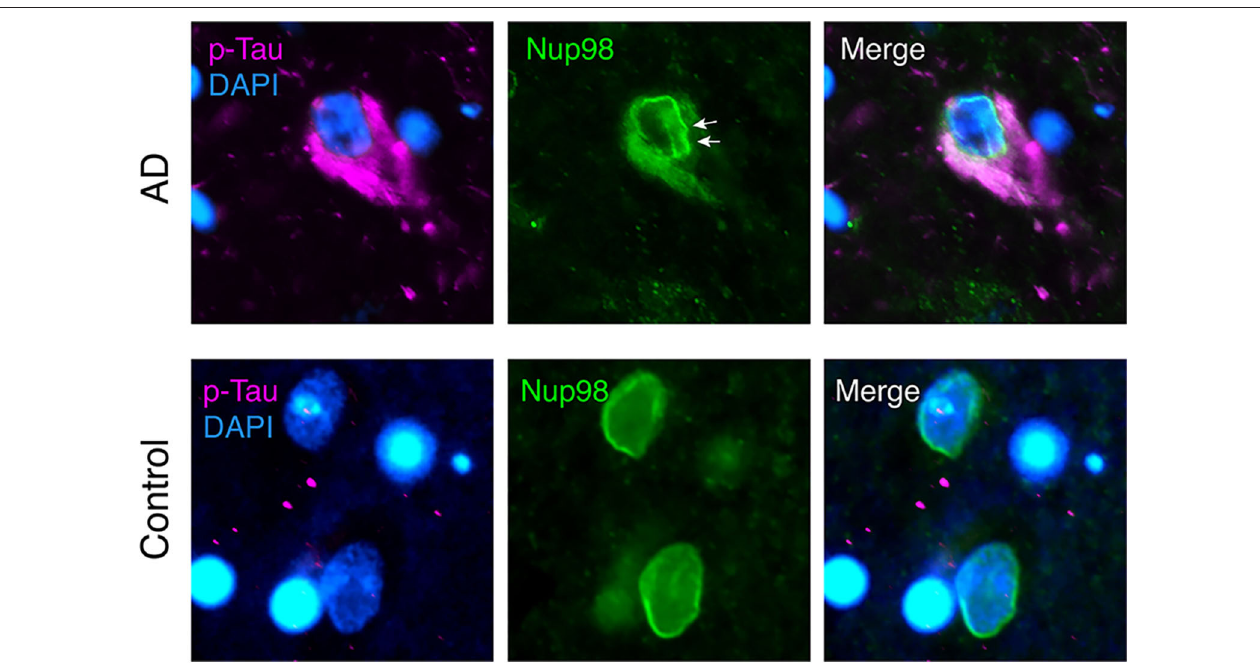
FIGURE 1 | Nuclear envelope distortion and cytoplasmic mislocalization of Nup98 in neurofibrillary tangles (NFTs) of Alzheimer’s disease (AD) brain. Human AD (Braak V) and age-matched control brain sections were immunolabeled for phospho-tau (magenta; p-tau mix of anti-phospho-tau antibodies, pS199, pT205, pS262, pT231, and pS409), Nup98 (green), and Dapi (blue). In AD cortex, NFTs filled with phospho-tau show a crinkled/distorted nuclear envelope (white arrows) and Nup98 accumulation in the cytosol. In control nuclei, Nup98 is localized evenly to the nuclear